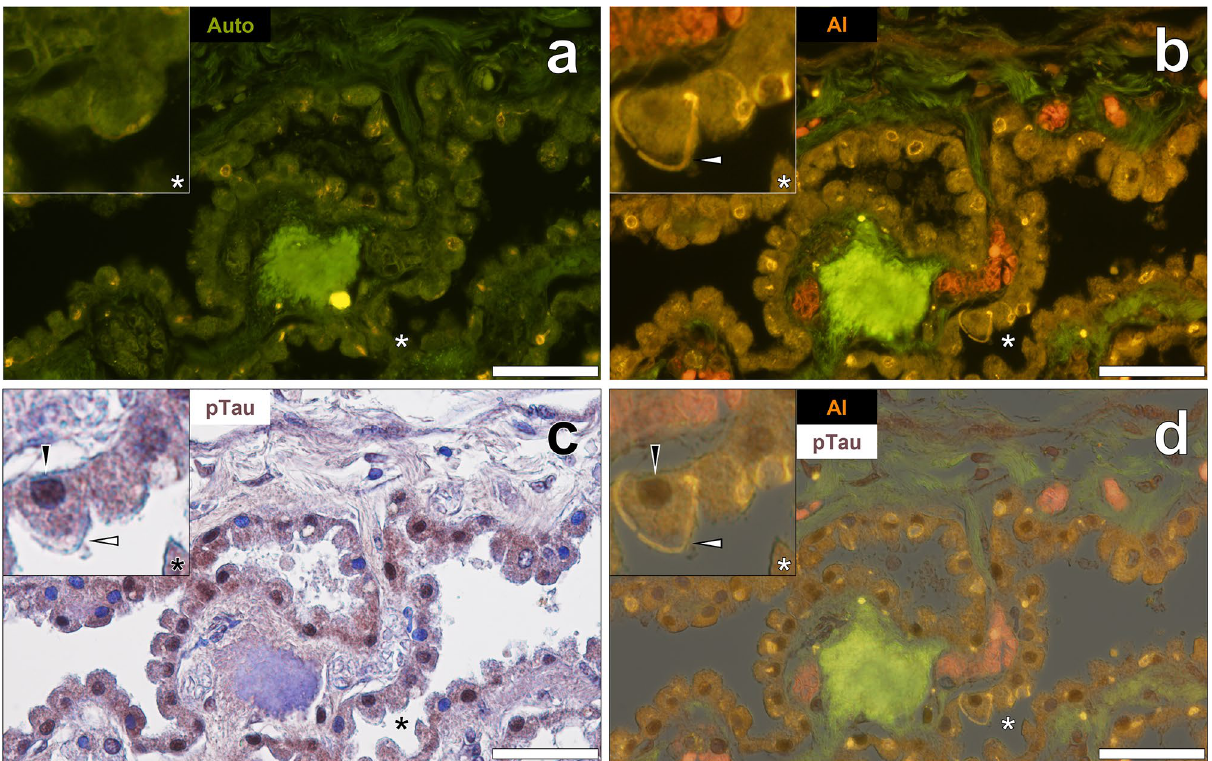
Figure 3. Aluminium is intricately associated with Biondi ring tangles in epithelial cells lining the choroid plexus adjacent to the hippocampus of a 67-year-old female donor with Parkinson’s disease. ( a ) Autofluorescence (green) highlighting intracellular lipofuscin-like (yellow) fluorescence. ( b ) Aluminium (Al) in cytoplasmic Biondi tangles (orange) in epithelial cells (white arrows) with ( c ) AT8 immunolabelling of phosphorylated tau (pTau) noted in cell nuclei (black arrows). ( d ) Merging of the brightfield and lumogallion fluorescence channels identified Biondi tangles and pTau in the same cells. Asterisks denote magnified inserts. Magnification: × 400, scale bars: 50